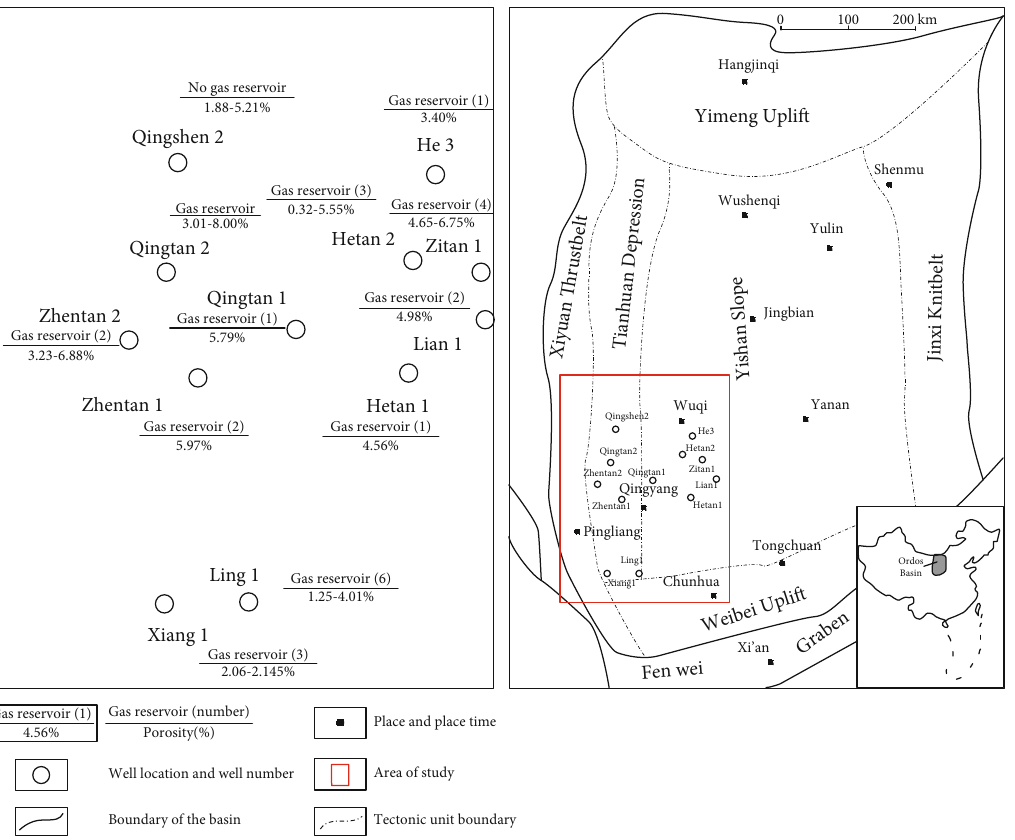
Figure 1: Locations of wells and regional structural location map in the study